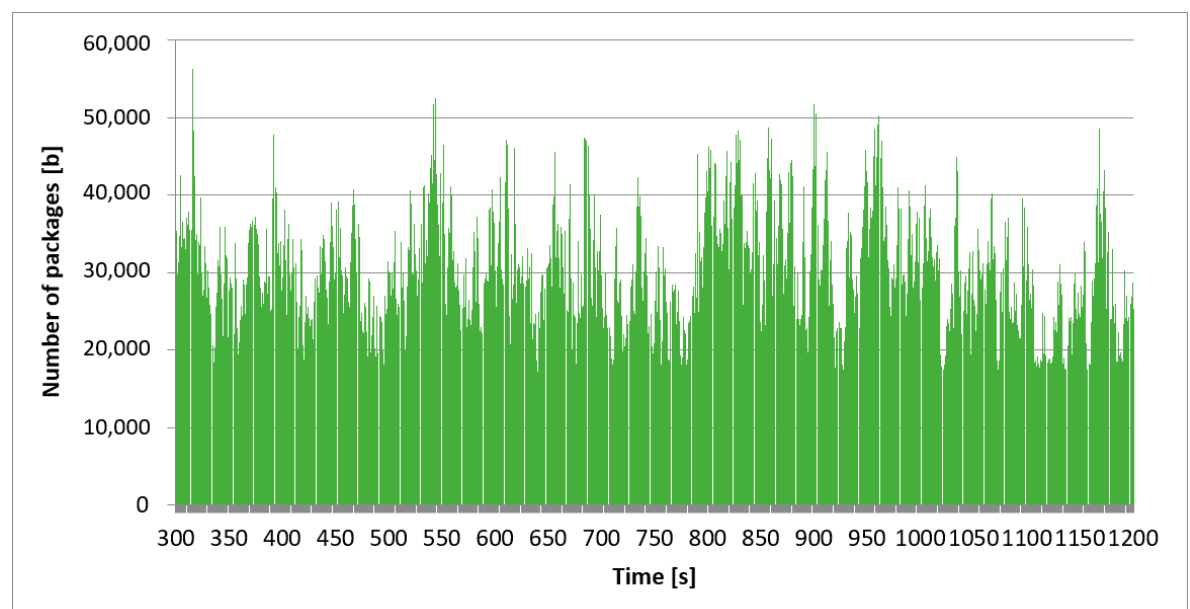
Figure 4. Overall network traffic over 900 s.